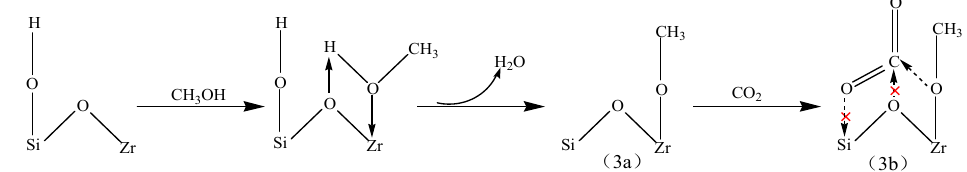
（ 3a ） Scheme 3. Synthetic routes for the m-CH 3 OC(O)O-Zr(Si) on the Zr/SBA-15 catalyst. Scheme 3. Synthetic routes for the m-CH 3 OC(O)O-Zr(Si) on the Zr/SBA-15